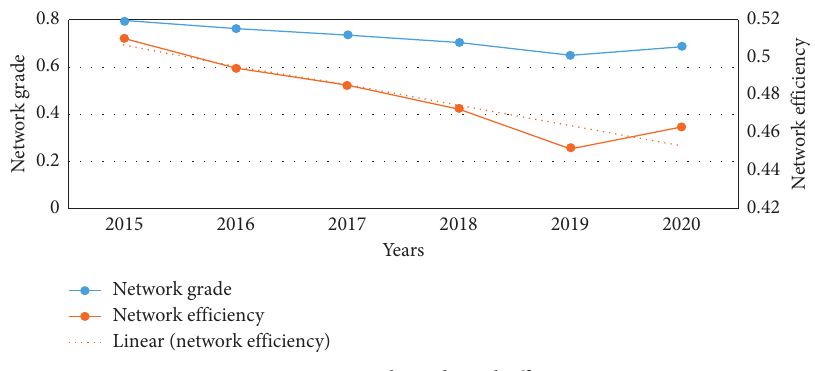
Figure 4: Network grade and efficiency. Table 3: Analysis of the centrality of the spatial correlation network of the innovation efficiency of the IM enterprises. Enterprise